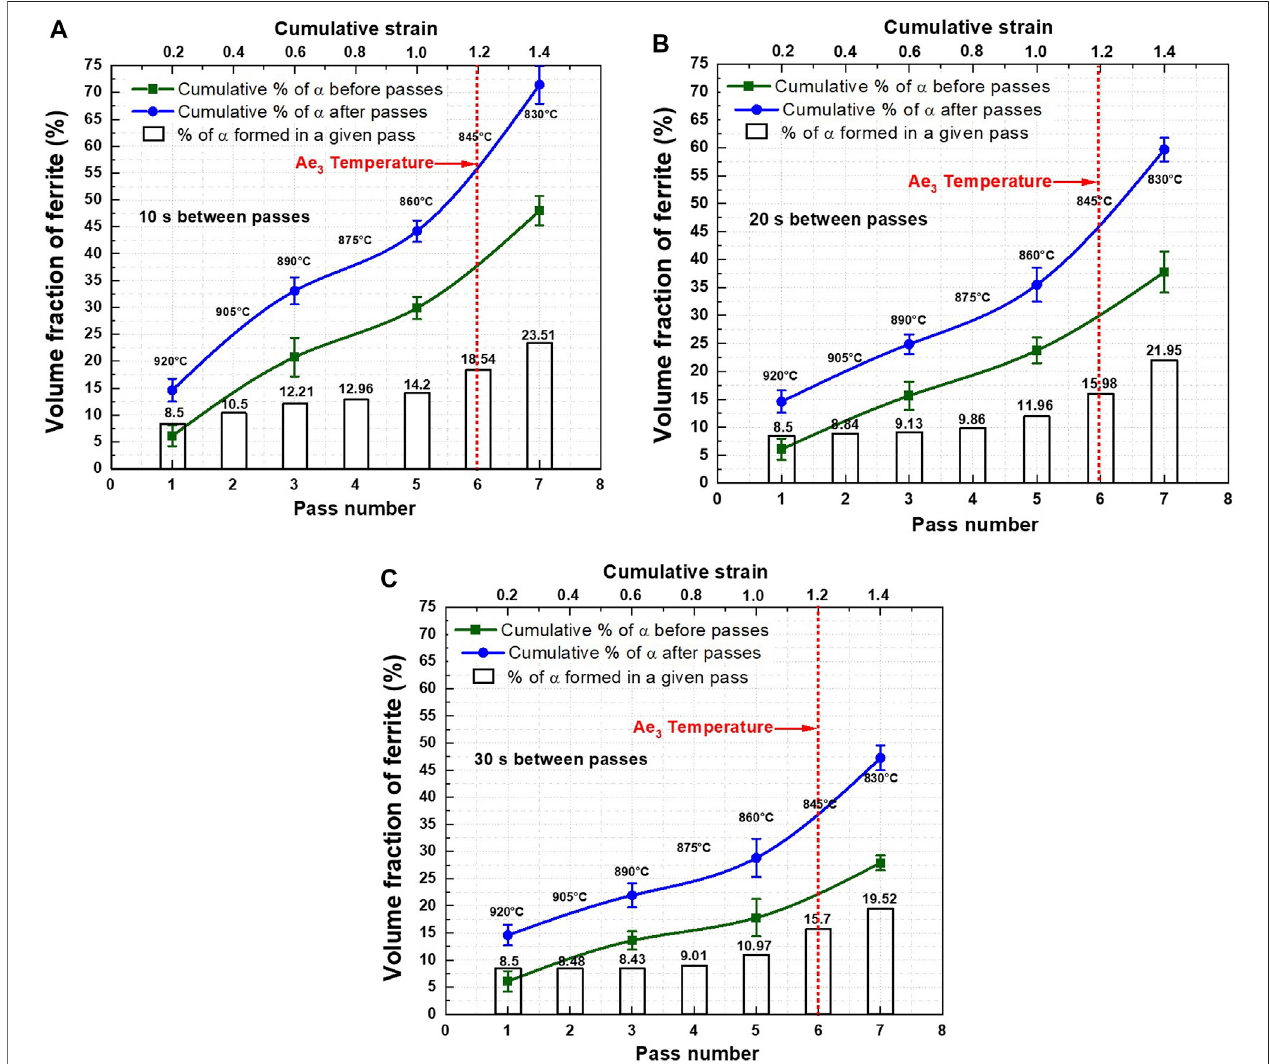
FIGURE 8 | The cumulative volume fraction of ferrite before and after each pass for simulations with interpass times of: (A) 10 s, (B) 20 s, (C) 30 s.